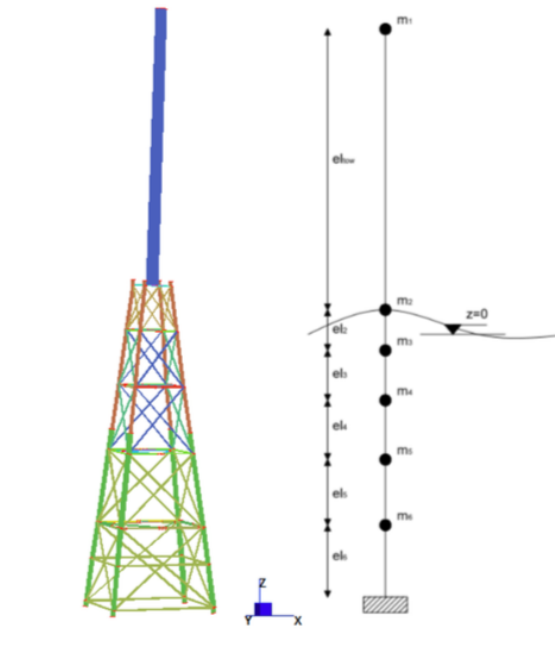
Figure 8. Wind tower